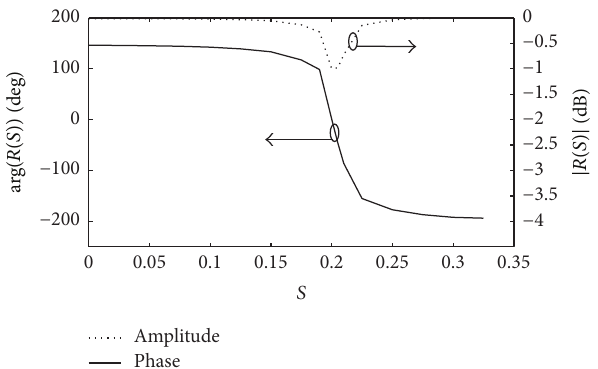
Figure 11: Simulated reflection coefficient versus 𝑆 ( 𝐿 = 7.86 mm, Δ𝑥 × Δ𝑦 = 0.5𝜆